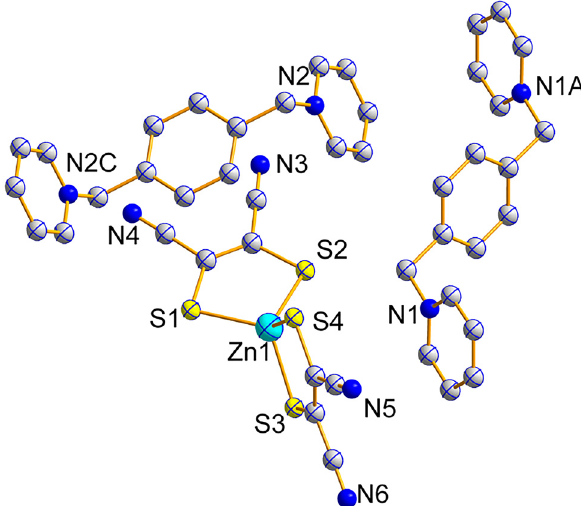
Table 1 contains crystallographic data and Table 2 contains the list of the atoms including atomic coordinates and displacement